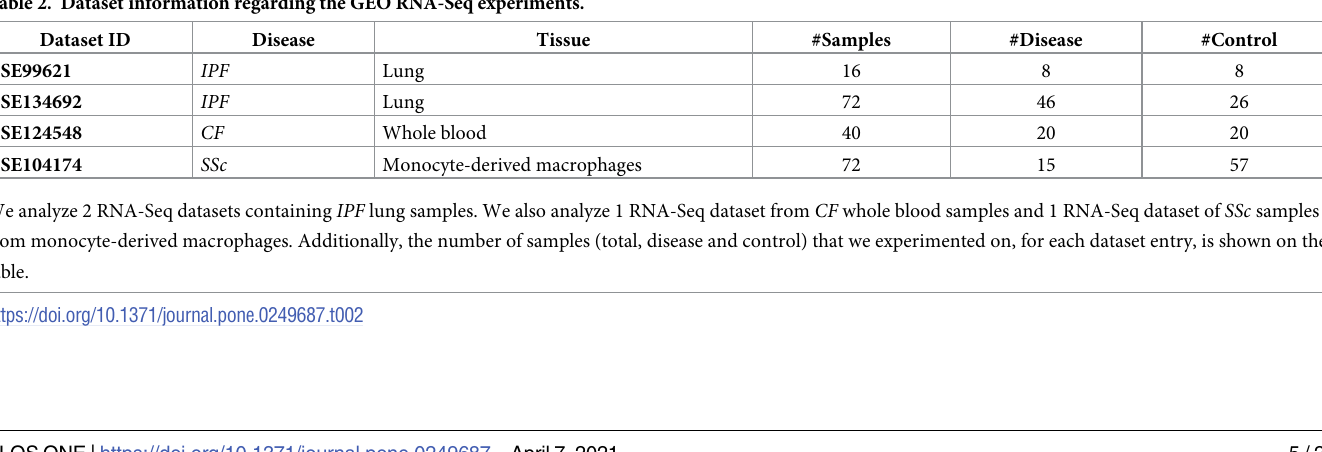
Table 2. Dataset information regarding the GEO RNA-Seq experiments. Dataset ID